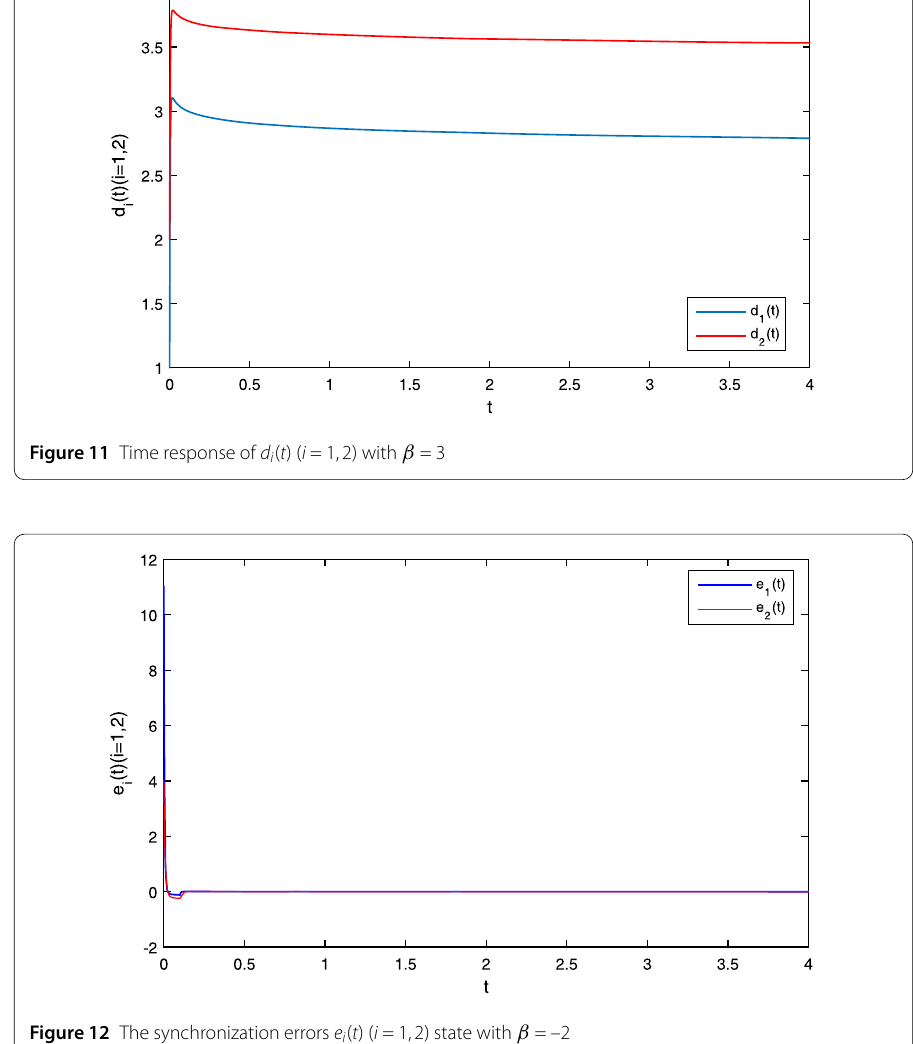
Similarly, projective synchronization with projective coefficient β = –2 is shown in Fig. 12–Fig.